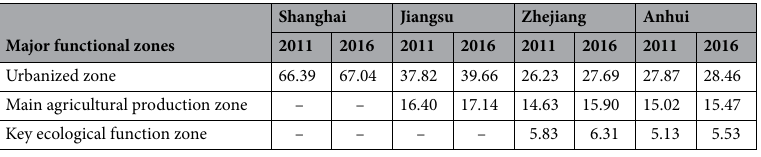
Table 2. LDI of each province (city) in different major functional zones.